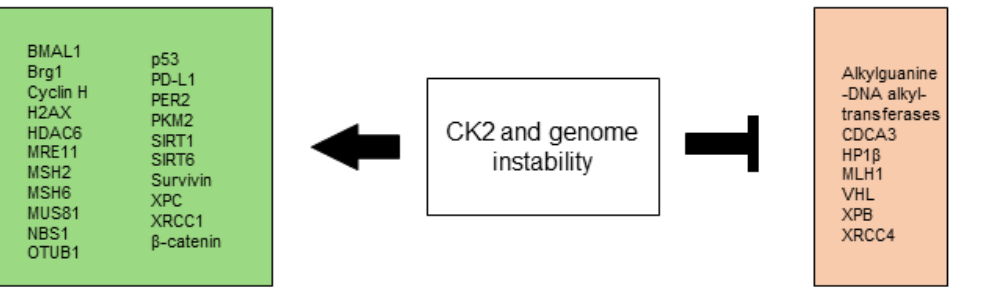
Figure 7. CK2-dependent modified proteins involved in genome instability. Proteins that are activated in this process by CK2 modification are shown on the left (highlighted in green), and proteins that are restricted in their function are shown on the right (highlighted in red).